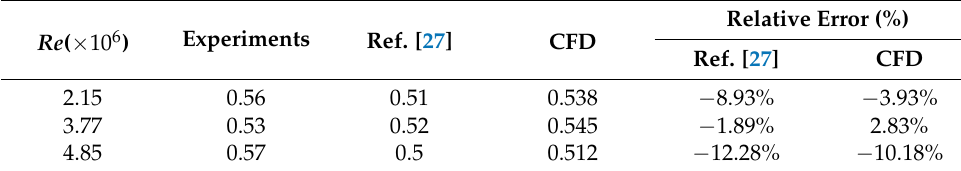
Table 2. Comparison of the drag coefficient between simulations and experiments and previous sim- ulations.